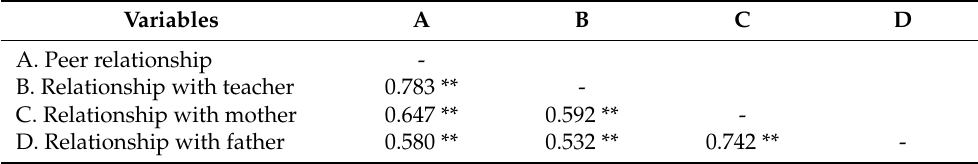
Table 2. Correlation analysis between dimension of TRI in the high school students.